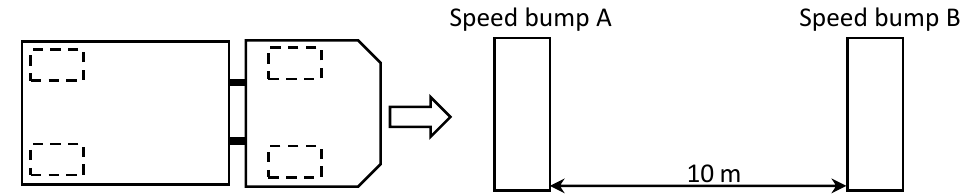
Figure 20. A sketch presenting a computer simulation of driving over speed bumps.